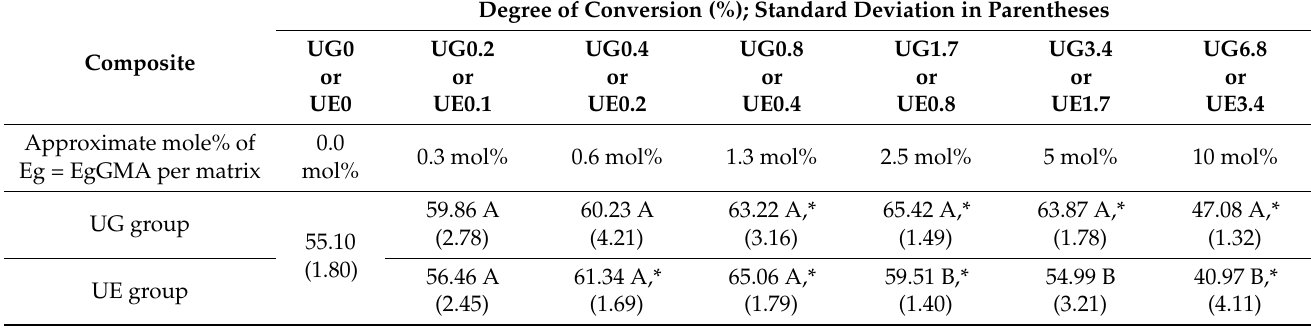
Figure 4. FTIR peaks in the range between 1675 and 1410 cm −1 of selected composites: the control (UG0 = UE0) ( A ), and composites with the highest rate of EgGMA (UG6.8) ( B ), before and after the light-curing process. Table 2. Degree of conversion (DC) of the experimental composites, UG and UE groups ( n = 5).